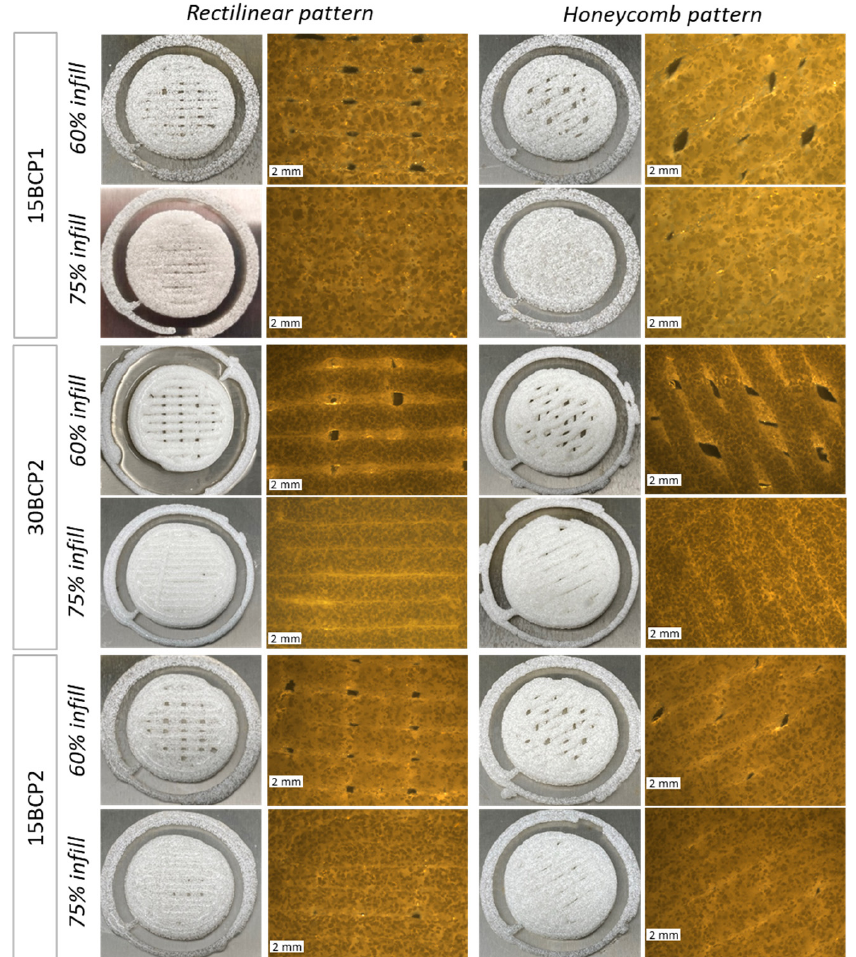
Figure 7. Photographic and microscopic images of disks printed with different parameters. Scale bars: 2 mm.